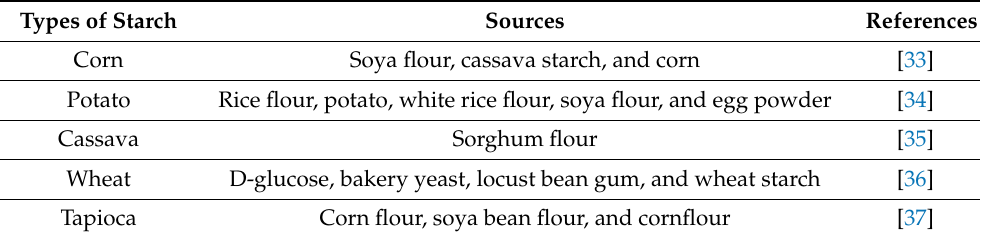
Table 1. Sources of starches and their types.